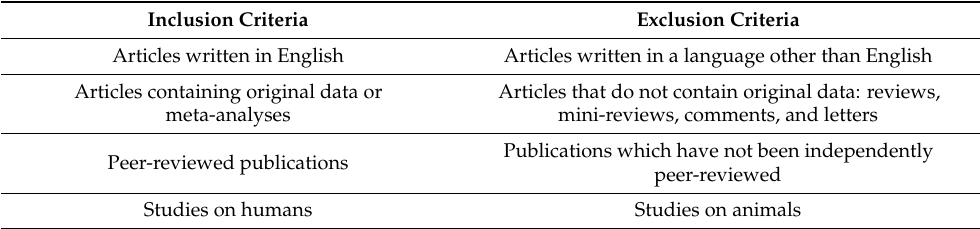
Table 1. Article inclusion and exclusion criteria.